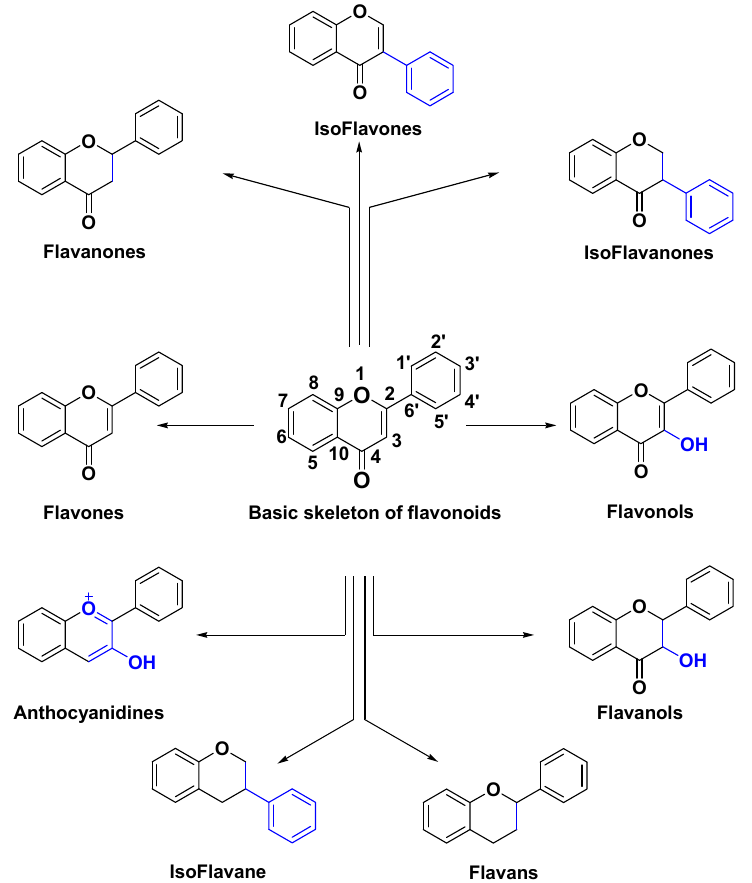
Figure 2. Chemical structures of classes of flavonoids.